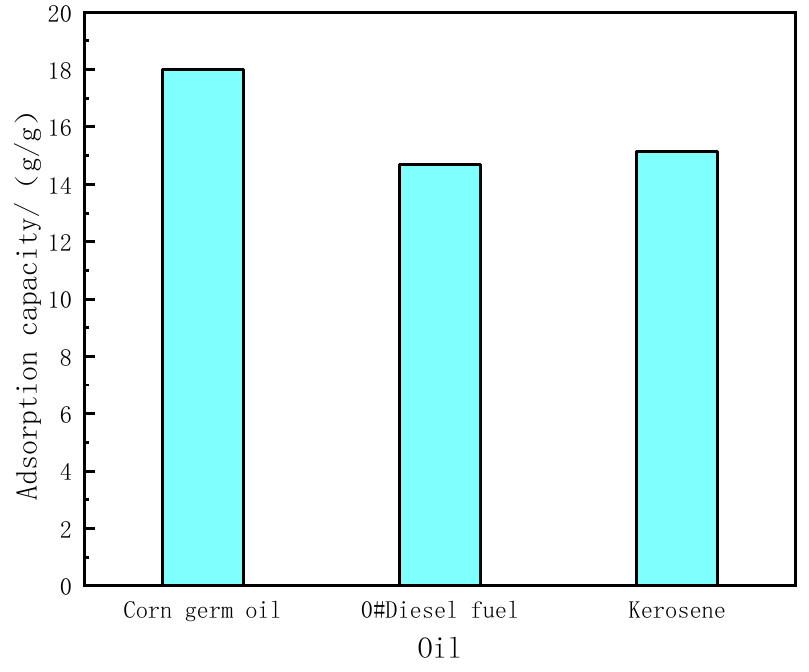
Figure 7. The oil absorption capacity of PDMS@Fe 3 O 4 /MS for different oils. Table 1. Comparison of adsorption capacity of MS and PDMS@Fe 3 O 4